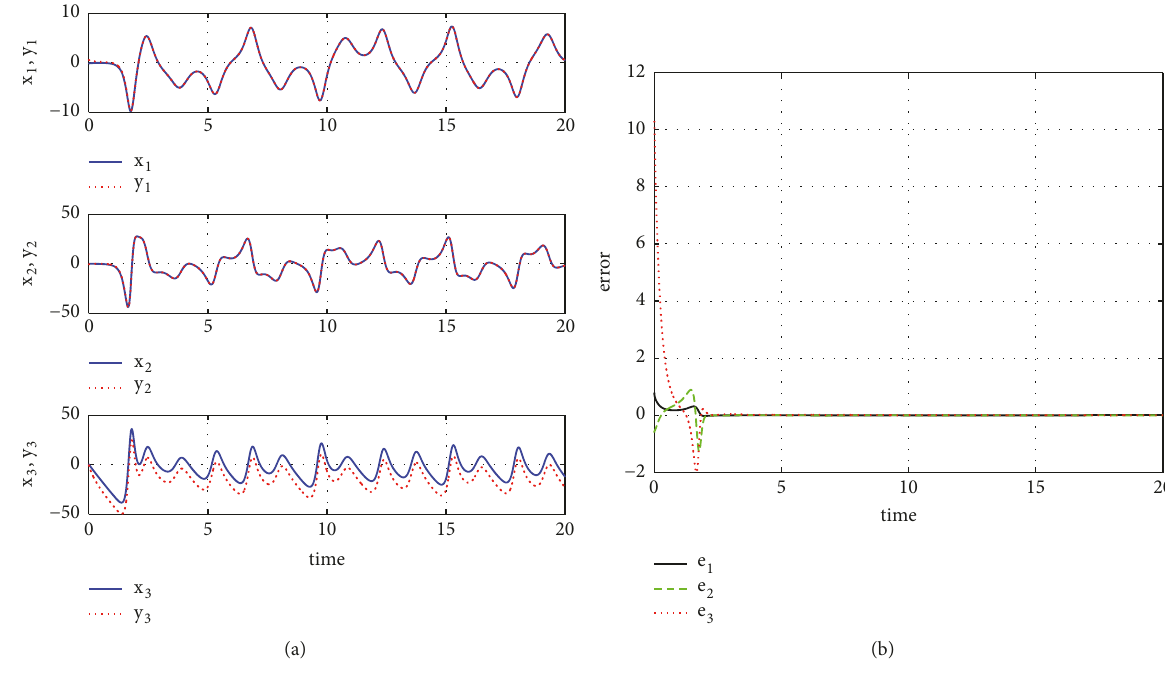
Figure 10: Partial phase synchronization with k 2 =10, k 3 =4, and c =1: (a) time response; (b) synchronization